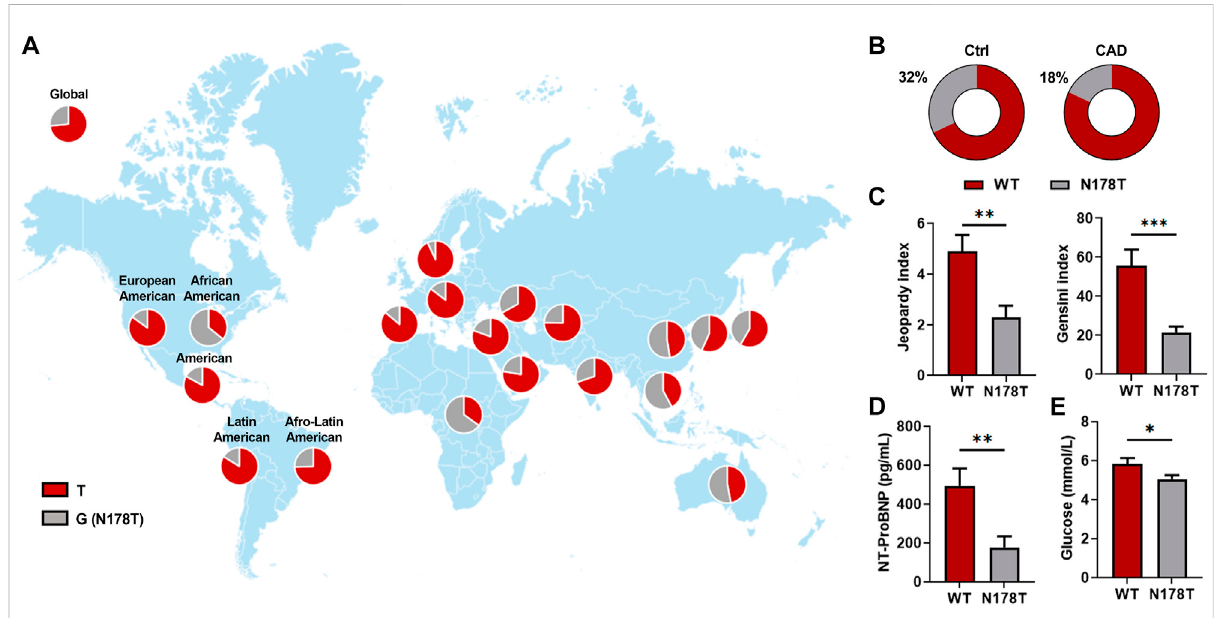
FIGURE 2 N178T P2Y 4 variant is associated with reduced cardiac severity scores and lower fasting plasma glucose and NT-proBNP levels in CAD patients. (A) Worldwide distribution of c.533T > G (p.N178T) polymorphism in the human P2RY4 gene corresponding to individuals with the N178T P2Y 4 receptor mutation, obtained after dbSNP database analysis, compiling data from the ALFA project, 1000Genomes, 8.3KJPN, ExAC, gnomAD, GO Exome Sequencing Project, HapMap, HGDP-CEPH-db, KRGDB, MGP, SGDP_PRJ, and TOPMed. (B) On the left, frequency of the N178T mutationin50controlindividuals(Ctrl)andontheright,frequencyoftheN178Tmutationin50patientsdisplayingcoronaryarterydisease(CAD). (C) Reduced jeopardy and Gensini scores for CAD patients with the N178T mutation in the P2Y 4 receptor. (D,E) Reduced NT-proBNP (pg/ml) and